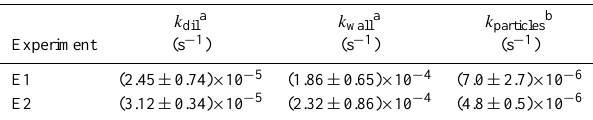
Table 5. Loss rates in Experiment E1 and E2. Particle loss given as model average particle loss rate (according to Eq. 7) in the first half hour of the sunlit